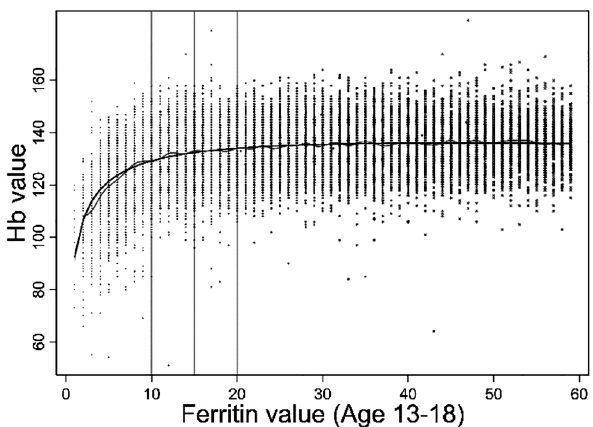
Figure 3: Correlation between serum ferritin (µg/L) and hemoglobin (g/L) results for a female population between 13 and 18 years, used to calculate functional reference limits, from Sezgin et al.